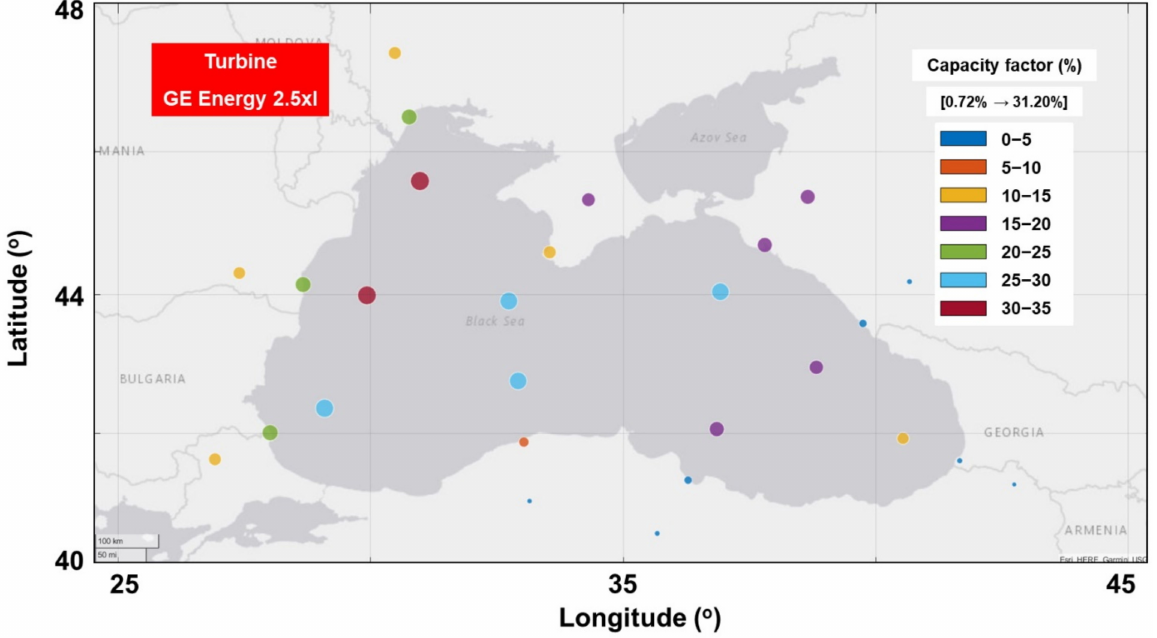
Figure 12. Capacity factor (in %) associated with the wind turbine GE Energy 2.5 xl. The numbers from the square brackets indicate the minimum and maximum values related to this